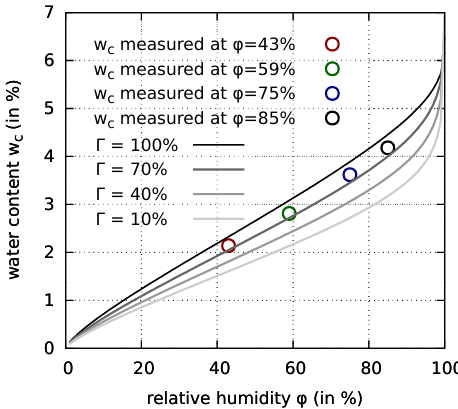
Figure 3. Calibrated desorption isotherm plotted for four different degrees of hydration Γ and four measured points corresponding to three different values of Γ close to 80% (cf. Table 2).